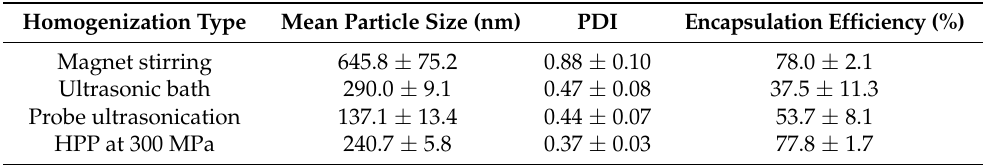
Table 1. Effects of different homogenization types on mean particle size, PDI, and encapsulation efficiency of CTP liposomes.